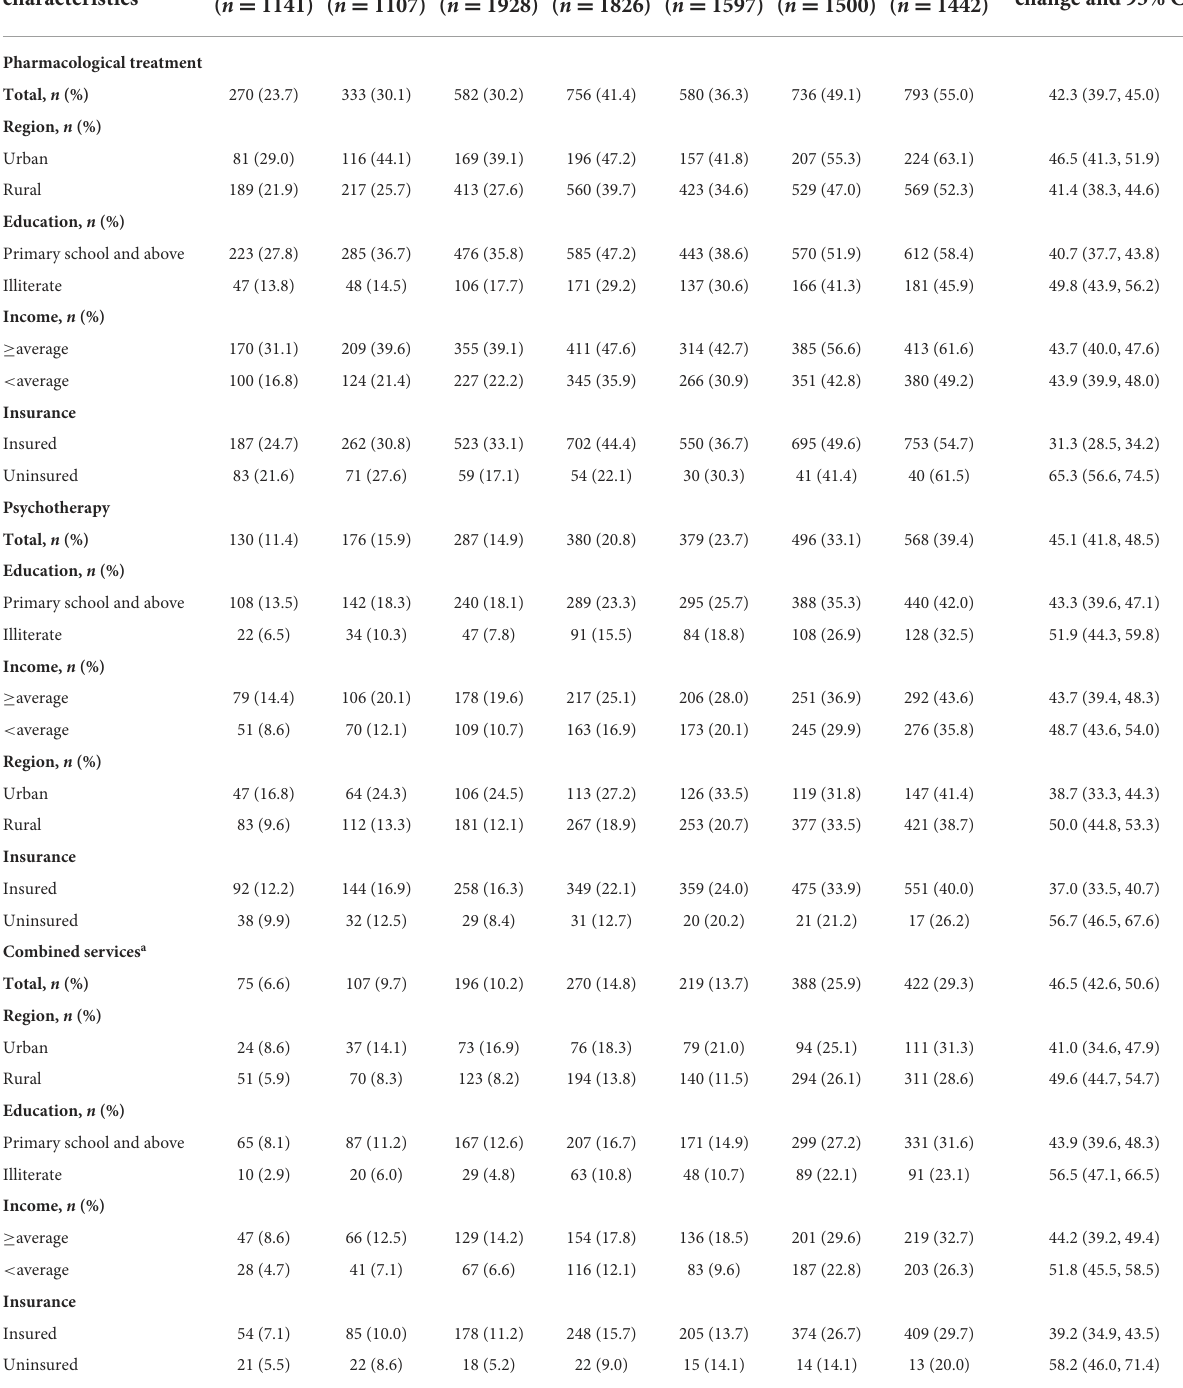
TABLE 2 Utilization rates of rehabilitation services among Chinese adults with schizophrenia, by socioeconomic characteristics, 2007–2013.